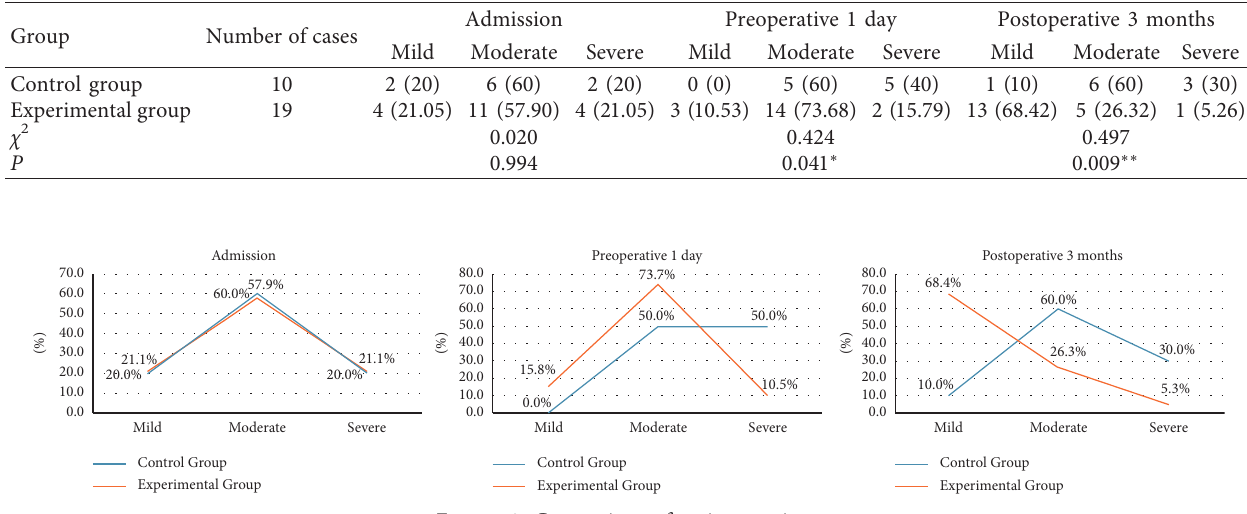
Figure 2: Comparison of patient anxiety. Table 4: Comparison of quality of life scores between the two groups (SF-36).